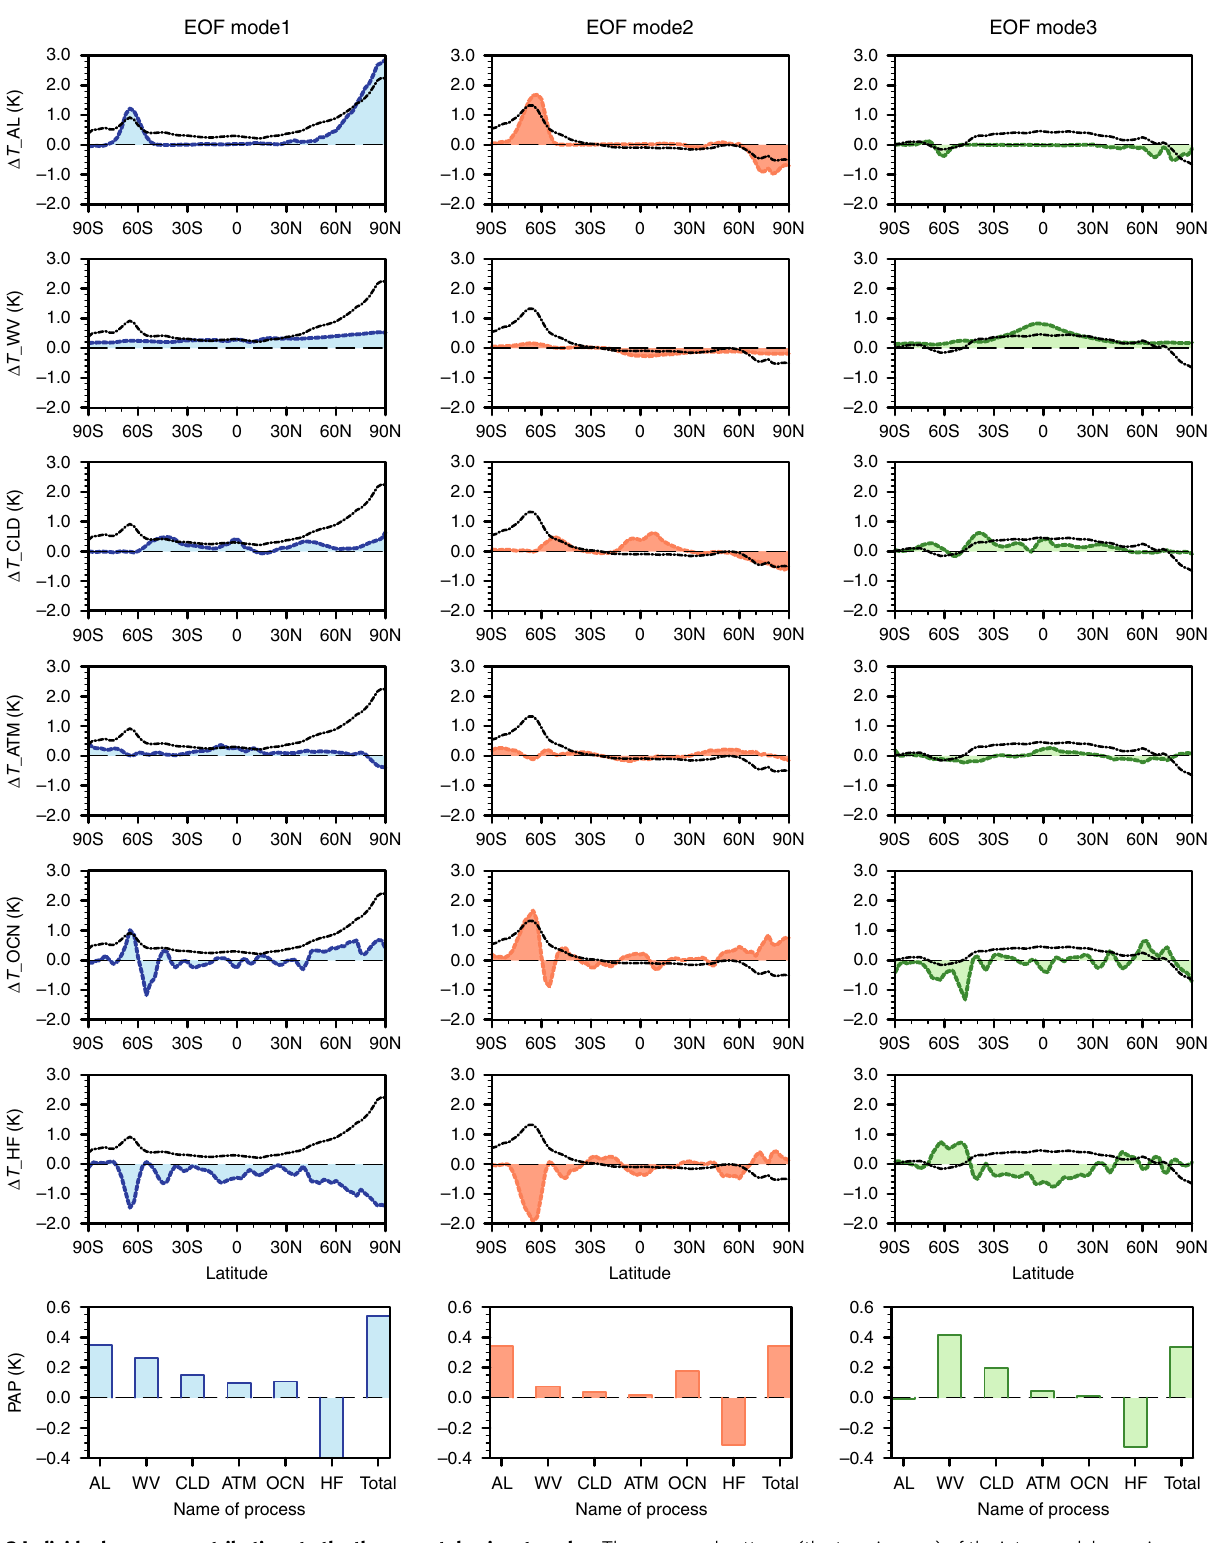
Fig. 3 Individual process contributions to the three most dominant modes. The regressed patterns (the top six rows) of the inter-model warming spreads in the individual (partial) surface temperature changes (Fig. 1e – j) against the principal components of EOF1 (empirical orthogonal function, the left column), EOF2 (the middle column), and EOF3 (the right column). The bottom row shows the pattern-amplitude projection (PAP) coef fi cients ( K ), measuring the contributions of individual processes to the fi rst three EOF patterns whose sum (i.e., the total) gives the root mean square amplitude ( K ) of the corresponding EOF mode (see the Methods section for details). The abbreviations AL, WV, CLD, ATM, OCN, and HF stand for processes of ice-albedo, water vapor, clouds, atmospheric dynamics, ocean dynamics plus heat storage, and surface turbulent heat fl uxes,